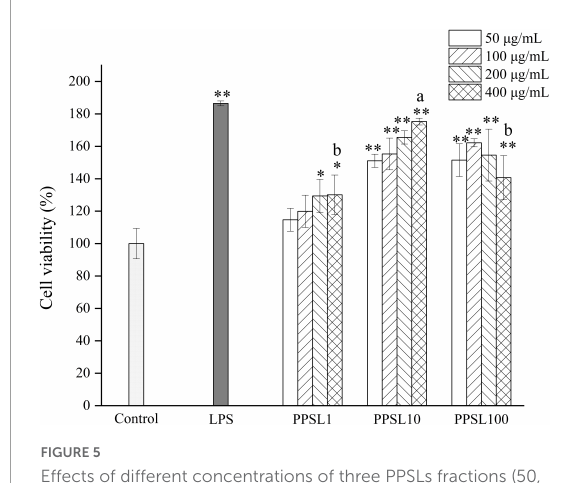
FIGURE5 Effects of different concentrations of three PPSLs fractions (50, 100, 200, and 400 µ g/mL) on cell viabilities of RAW264.7 macrophages. * p < 0.05, ** p < 0.01 vs. control group. The different letters (a, b) showed significant difference in the same concentration among three PPSLs fractions ( p <